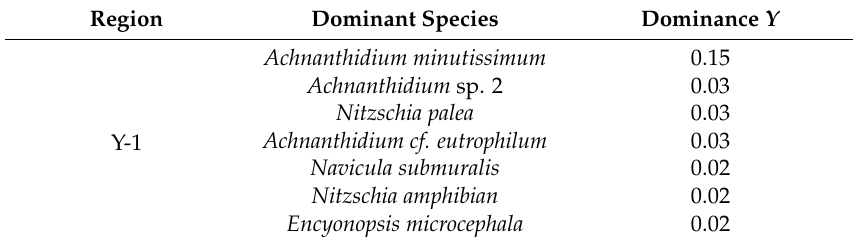
Table 2. Dominant species and dominance of benthic diatoms in Y-1, Y-2, and Y-3. Region